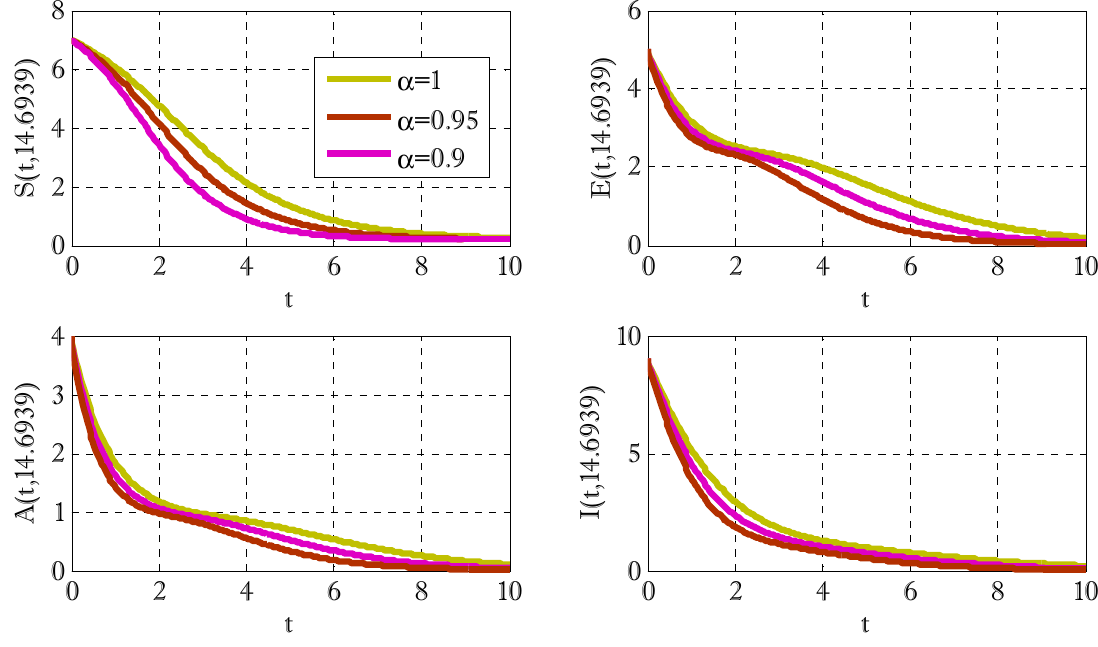
Figure 11. Impact of fractional order parameter α on susceptible, exposed, asymptomatic, and infected individuals using N x = 50, N t = 300, α 1 = 0.9, β = 0.9, γ = 0.7, σ = 0.9, µ = 0.9, d 1 = 2, d 2 = 2.5, d 3 = 2.5, d 4 = 2, d 5 = 2, L = 30.